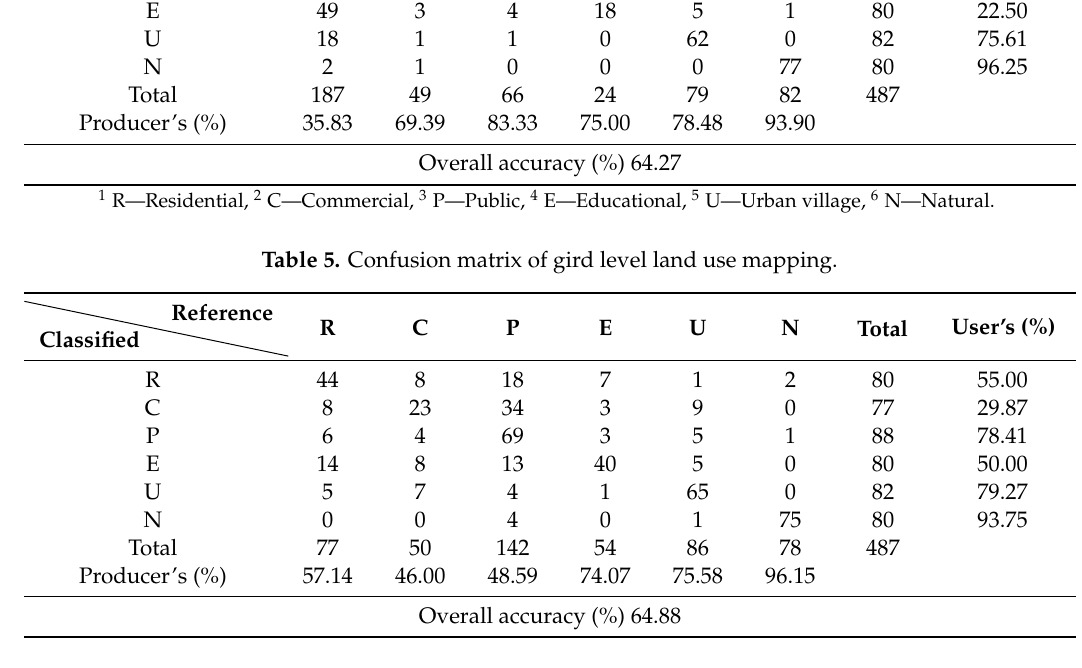
Table 6. Confusion matrix of object level land use